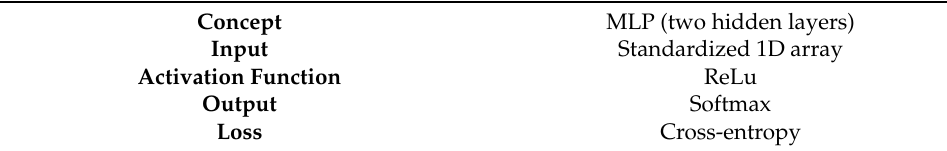
Table 2. Preset neural network